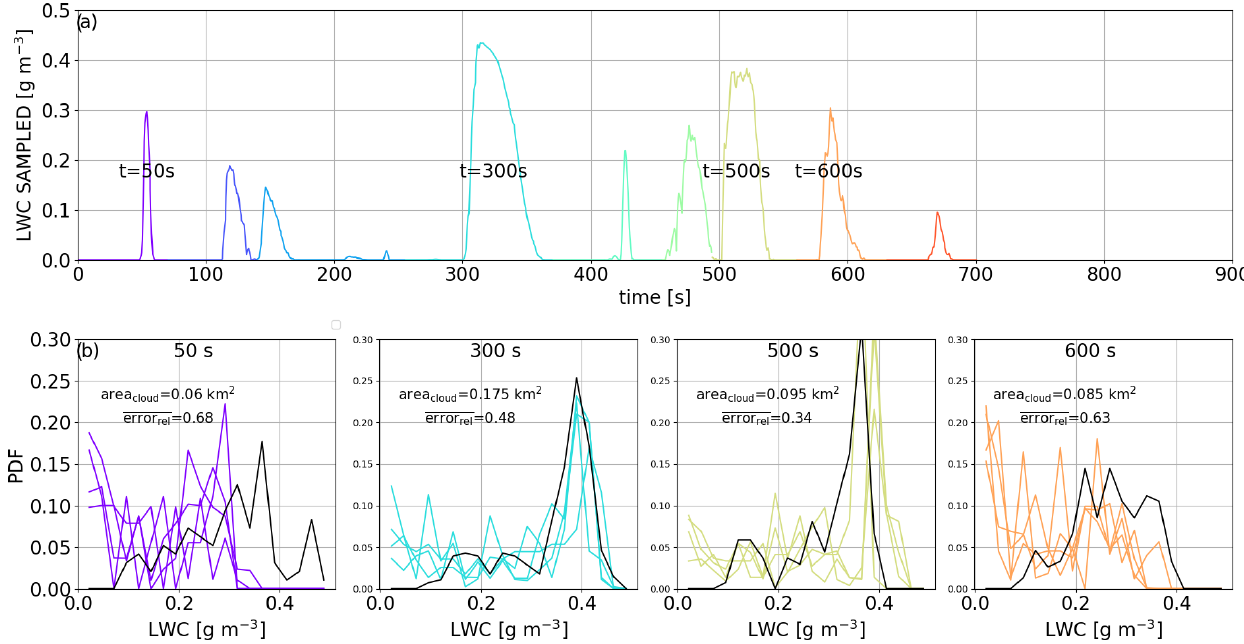
Figure 15. (a) Temporal evolution of LWC measured by RPA for different transects (colors). (b) Reconstructed probability function of LWC in color and by the reference in black for four transects of exploration (transects 1, 4, 7,